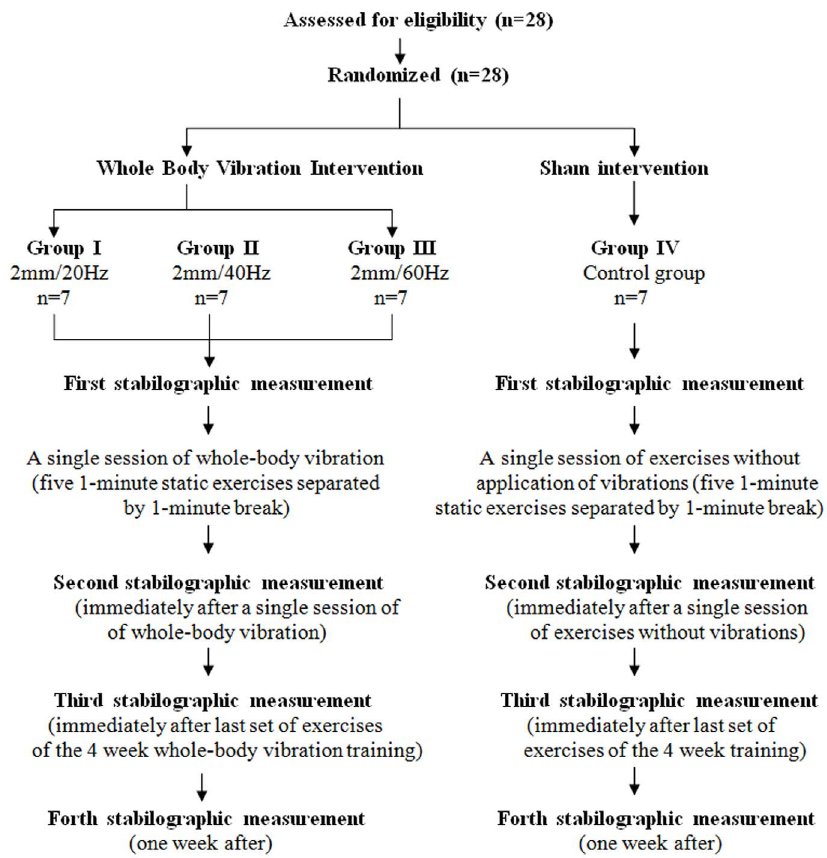
Figure 1. Flow diagram for study design.